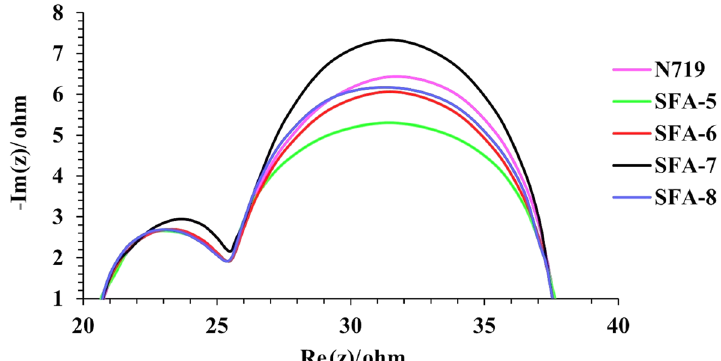
Figure 12. EIS Nyquist plots for DSSC sensitized with SFA-5–8 .